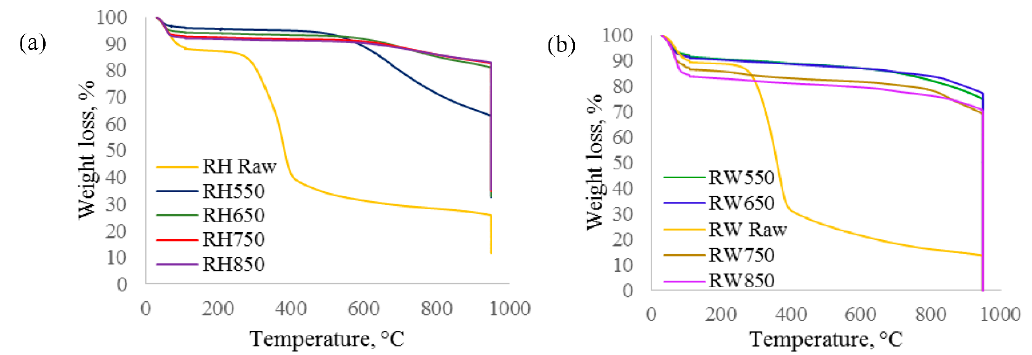
Figure 1. Thermogravimetric analysis curves for ( a ) rice husk derived biochar, ( b ) rubber wood derived biochar.